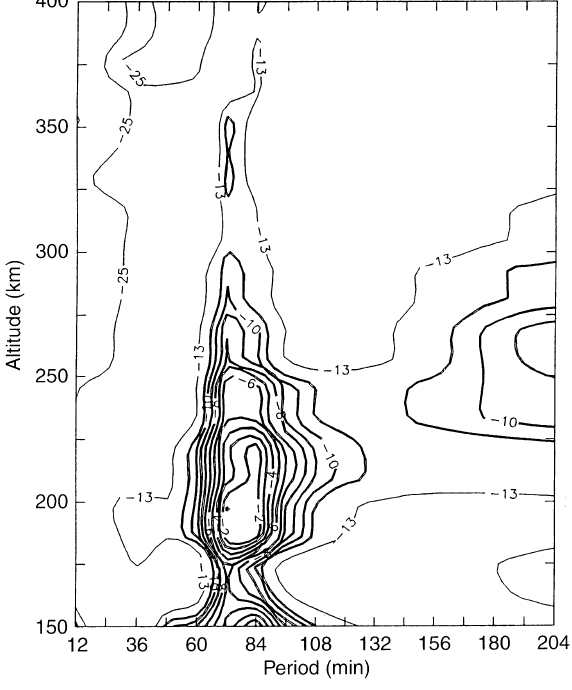
Fig. 3. Contours of the power spectral density of the N e -TID observed with EISCAT (CP2, position A) on 14 November 1990, from 0730-1130 UT